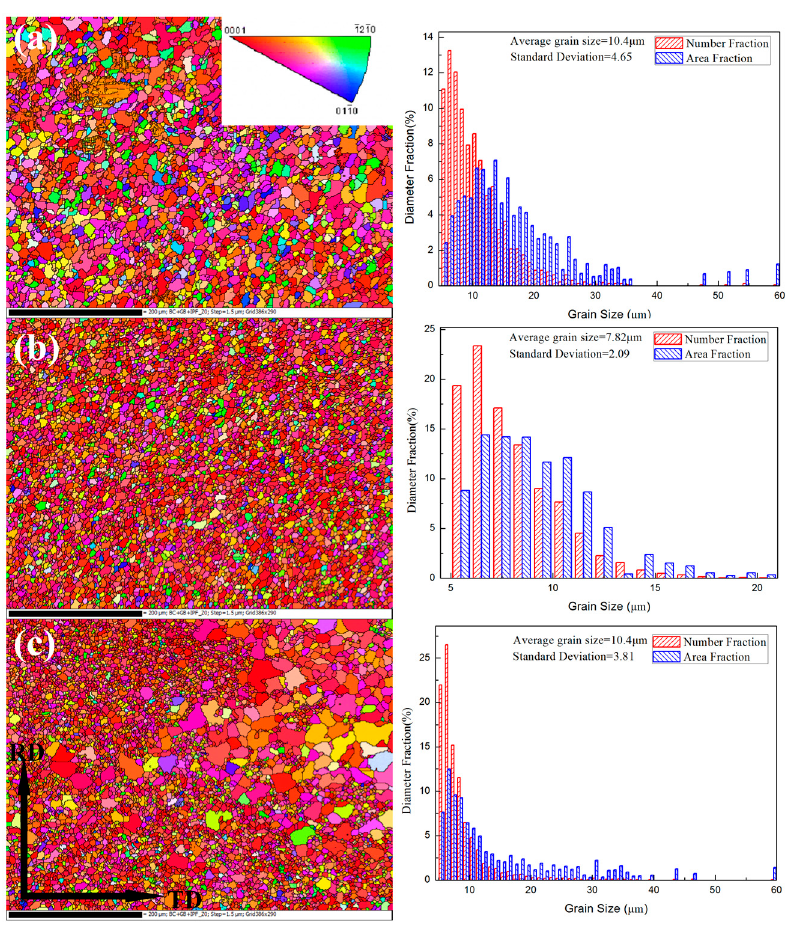
Figure 4. Electron back-scatter diffraction (EBSD) results of AZ31 alloys HSRMFed to 6 passes with different pass strains and accumulated strain: ( a ) 0.1/0.6, ( b ) 0.16/0.96 and ( c ) 0.35/2.1.